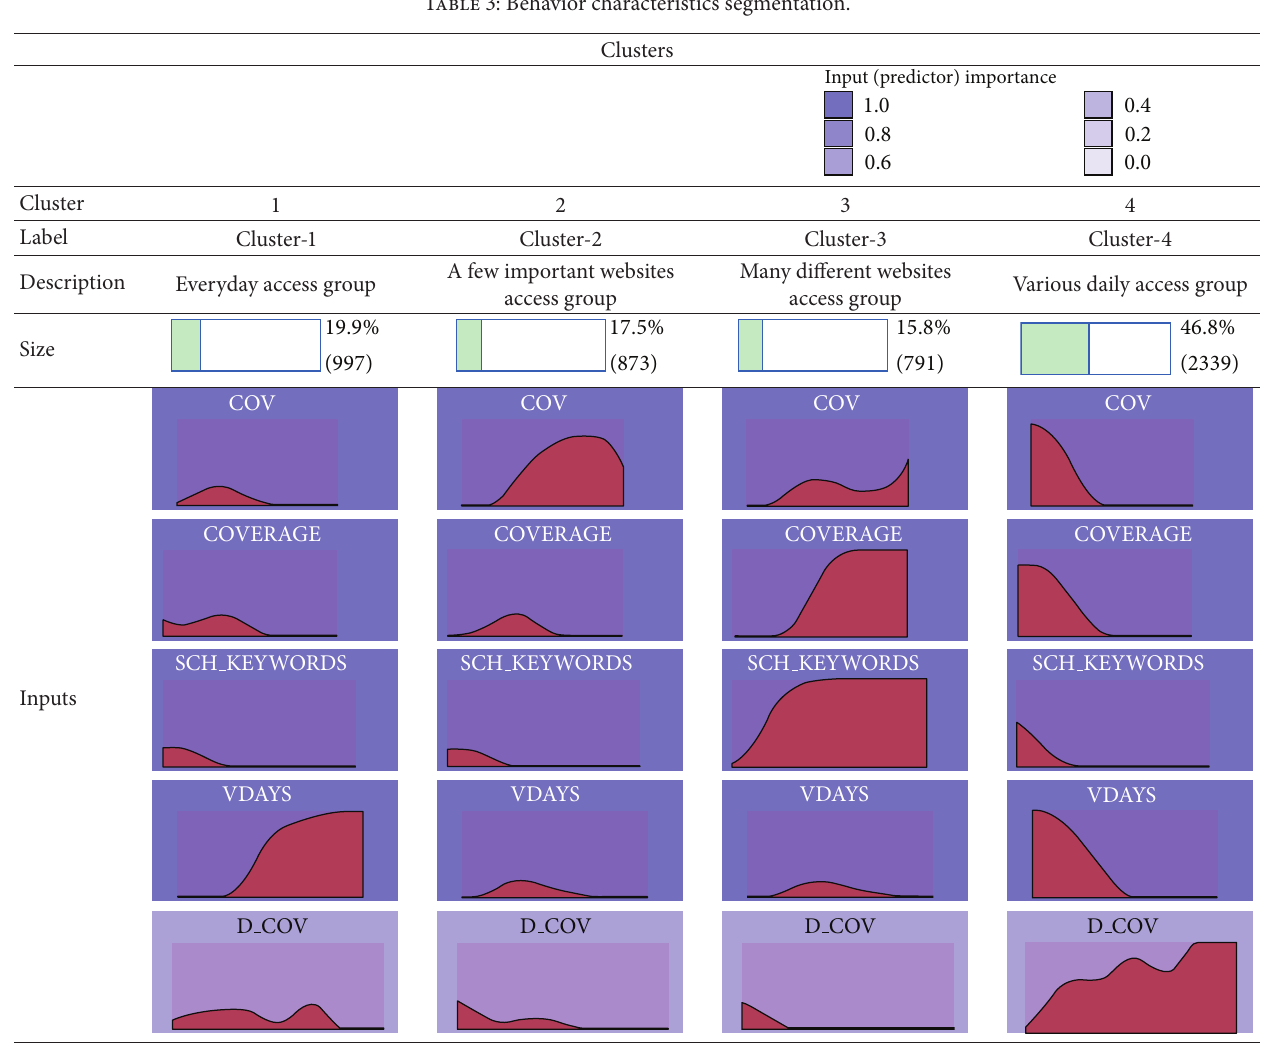
Table 3: Behavior characteristics